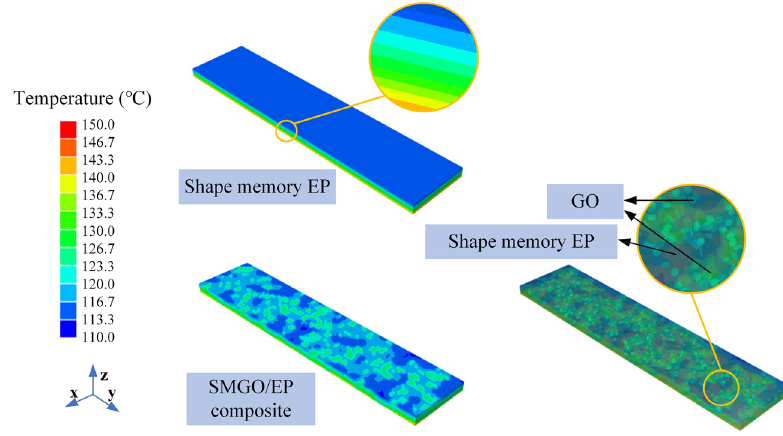
Figure 12: Comparison of temperature distribution of SMEP and SMGO/EP